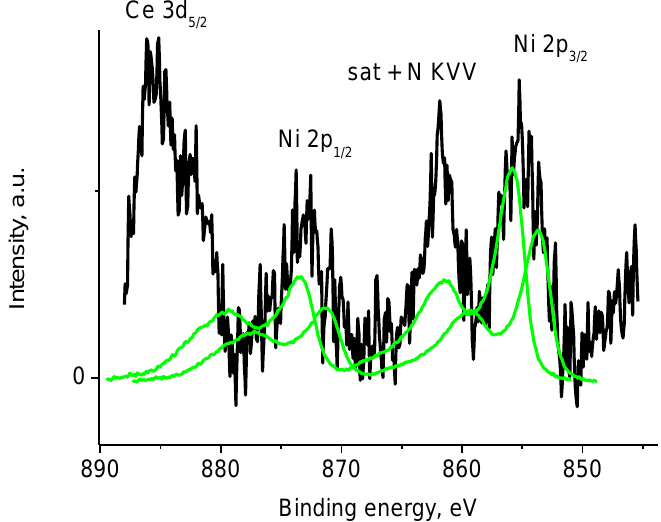
Figure 20. Photoelectron spectrum of sample 1 in the energy interval of Ni 2p spectrum (initial spectrum – black, Ni 2p spectra – green).